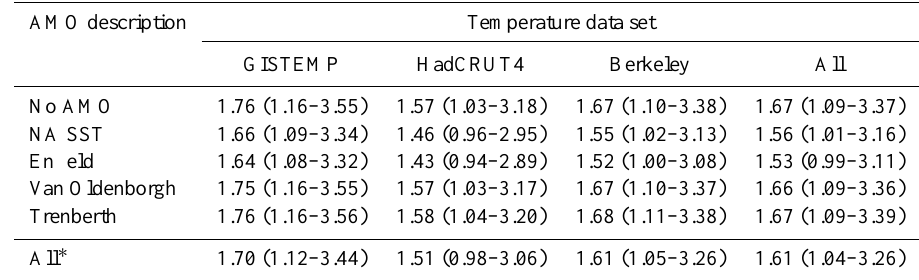
Table 1. Transient climate response (TCR, in ◦ C) including 5th and 95th percentiles based on Monte Carlo simulations taking into account uncertainties in radiative forcing, its regression coefficient, and temperature data.